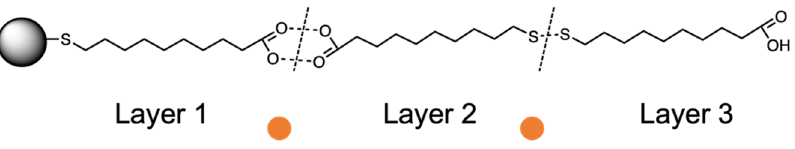
Figure 6. Schematic representation of the multi-layer arrangement for ML–AgNPs@11MUA on the surface of the NPs. indicates the metal ions that could disrupt MUA–MUA secondary interactions.